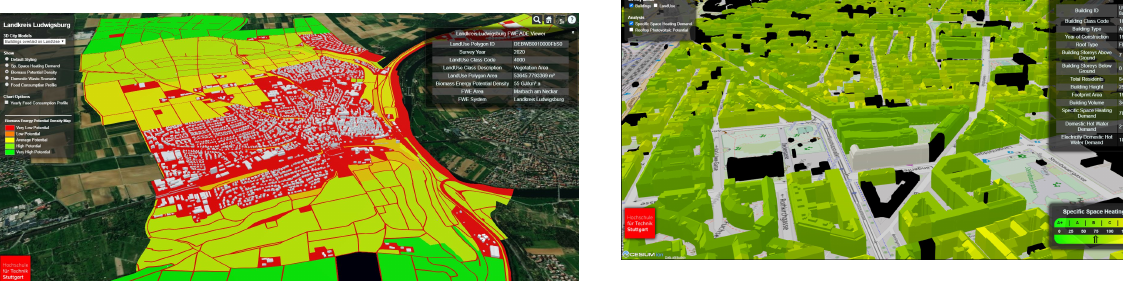
Figure 14. Meidling’s building stock heat energy demand